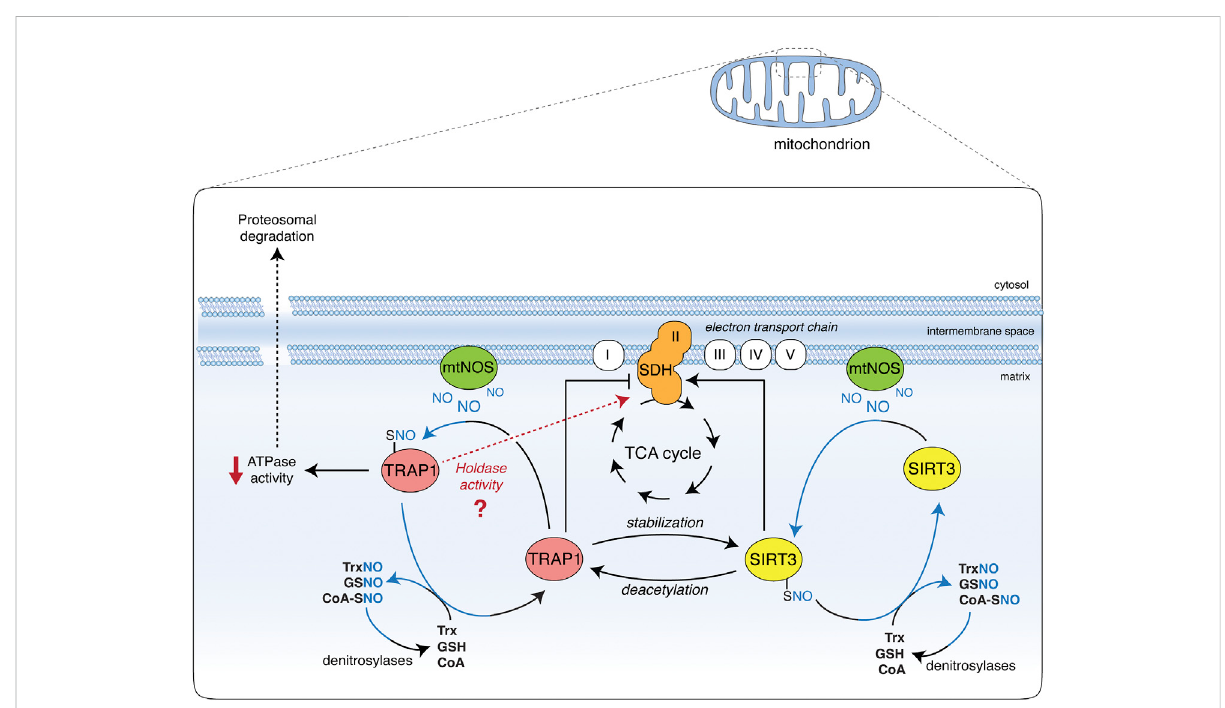
FIGURE 1 Effect of TRAP1 and SIRT3 S-nitrosylation on SDH . Nitric oxide (NO) is generated in the mitochondria by the mitochondrial portion of NOS2 (mtNOS).Besidesnitration-inducedirreversibledamage(notshown),itcausestheS-nitrosylationofTRAP1andSIRT3(TRAP1-SNOandSIRT3-SNO), which are in equilibrium with low molecular weight nitrosothiols (molecules and small proteins, such as GSNO, SNO-CoA, and TrxNO), the levels of which are controlled by denitrosylases (GSNOR, SCoR, and TrxR, respectively). S-nitrosylation increases SIRT3 activity, hence promoting succinate dehydrogenase (SDH) deacetylation and activation. SIRT3 has also been reported to deacetylate and activate TRAP1, which is crucial for SIRT3 protein stability. On the other hand, S-nitrosylation inhibits TRAP1 ATPase activity and promotes its degradation via the proteasome. Being TRAP1 a negative regulator of SDH, SDH activity is consequently increased. TRAP1 S -nitrosylation may also be responsible for a shift towards a holdase-like function of the protein (as recently proposed). This additional ability of TRAP1 could alternatively affect SDH stability and activity, and may help reconcile discrepancies between different studies on the effects of SIRT3 on SDH: if it takes place or not via TRAP1 inhibition or